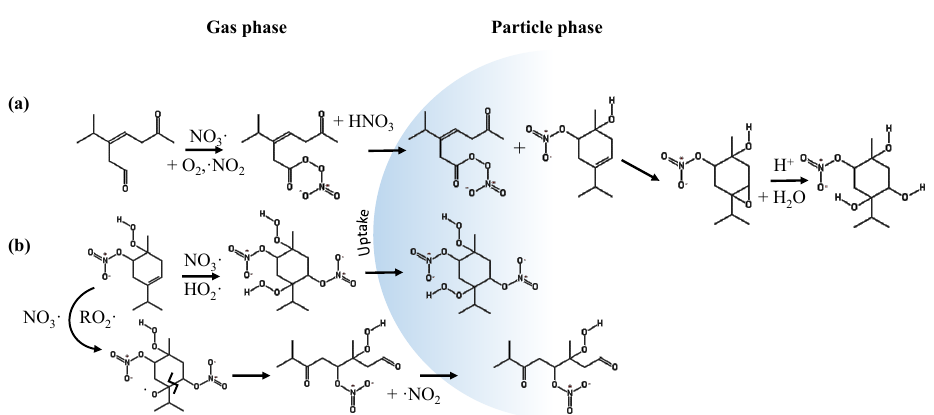
Figure 7. Potential second-generation oxidation reactions and particle-phase chemistry. (a) NO 3 oxidation of γ -terpinaldehyde and olefin epoxidation by peroxy acyl nitrate, followed by acid-catalyzed hydrolysis of the epoxide to form the diol. (b) RO 2 following NO 3 oxidation of the first-generation nitrooxy